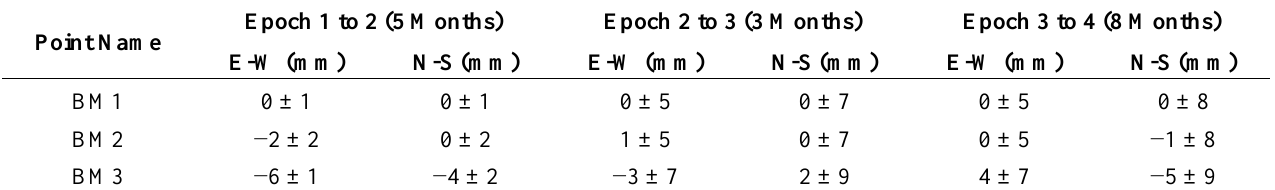
Table 3. GPS horizontal displacement from the reference network during the 16 month time interval between the first and the fourth campaign with 95% confidence